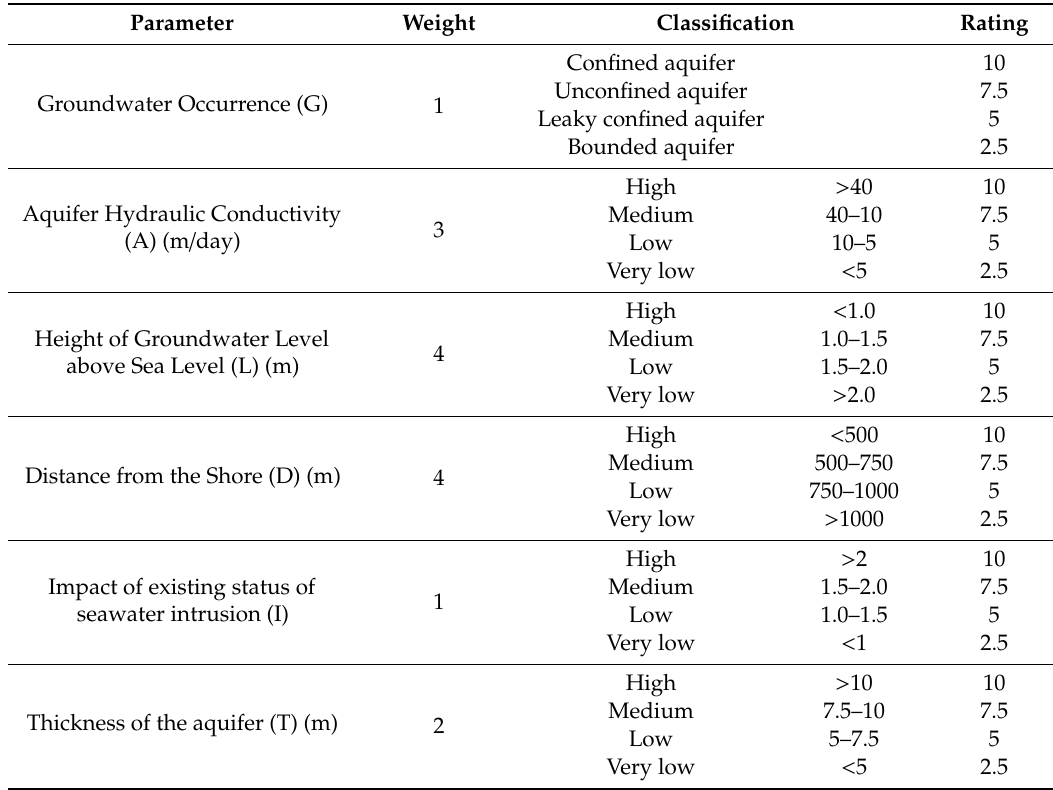
Table 1. Rating of GALDIT